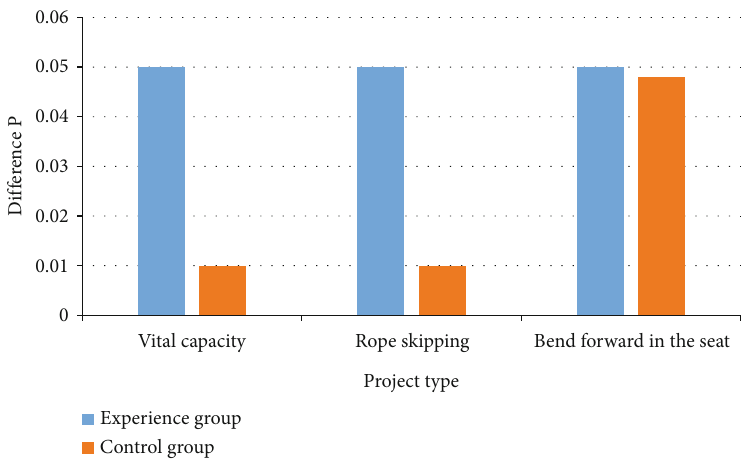
Figure 1: The e ff ect of Taijiquan on the physical health index of college students.